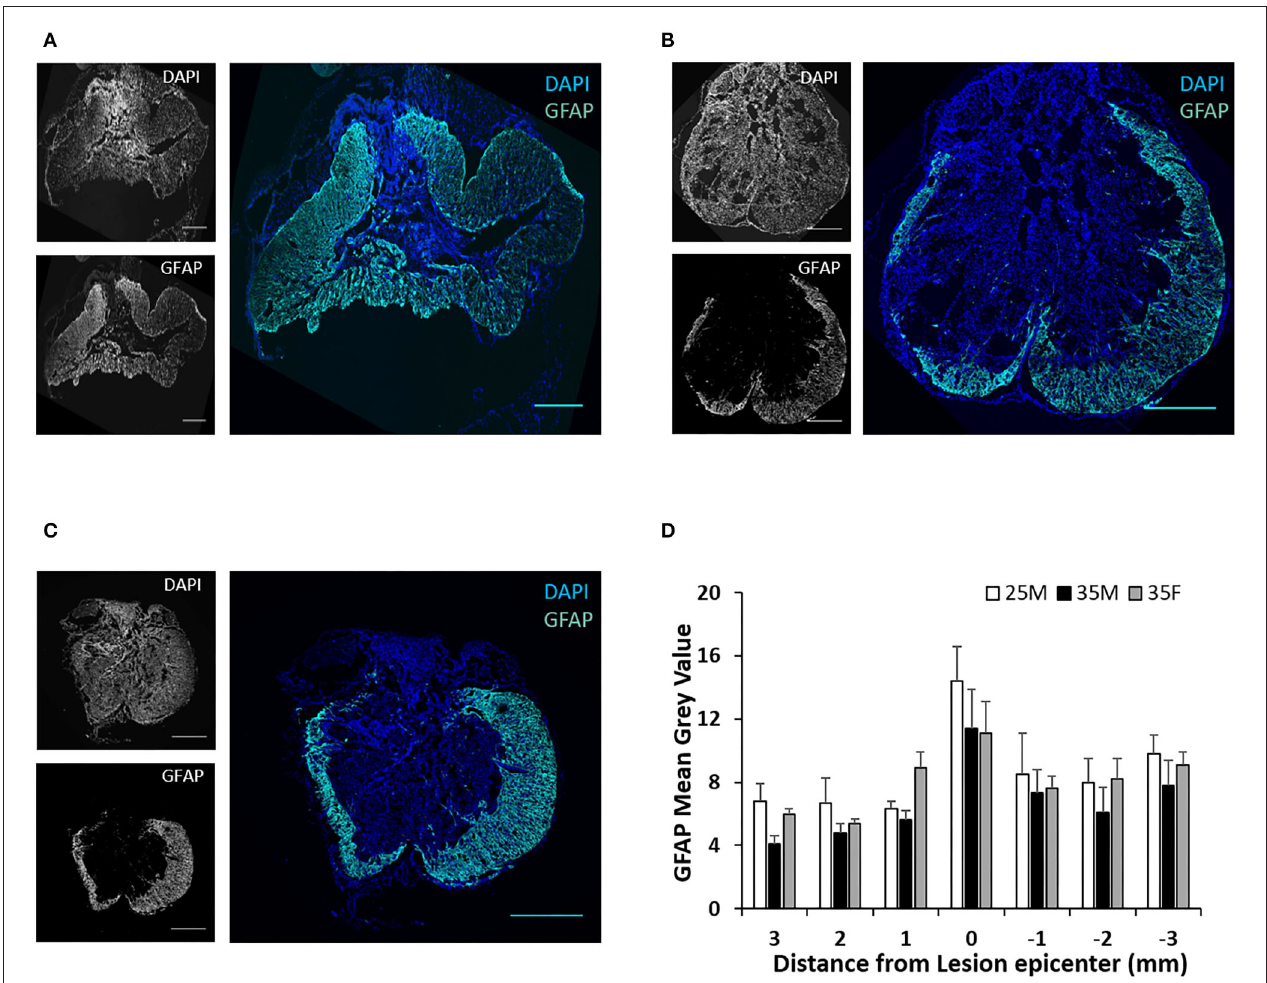
FIGURE 5 | Astroglial scar at the lesion epicenter following SCI. (A–C) Fluorescence images of the lesion epicenter of 25M (A) , 35M (B) , and 35F (C) groups, DAPI (blue), GFAP (teal). (D) Quantification of fluorescence intensities of GFAP at various distances from the lesion epicenter. Data are presented as mean + SEM. Scale bar shows 500 µ